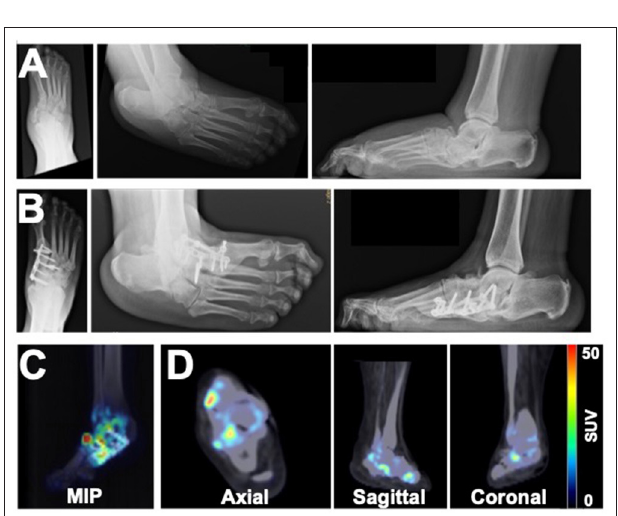
FIGURE 2 | Imaging assessment of a 49-year old female patient with a history of right foot Charcot deformity. X-rays were acquired at (A) the time of navicular bone removal and (B) 5 years after surgical reconstruction of the foot. (C) MIP and (D) PET/CT images acquired 5 years after surgery revealed heterogeneous boney uptake of 18 F-NaF and suggested potential for ongoing remodeling of the foot.